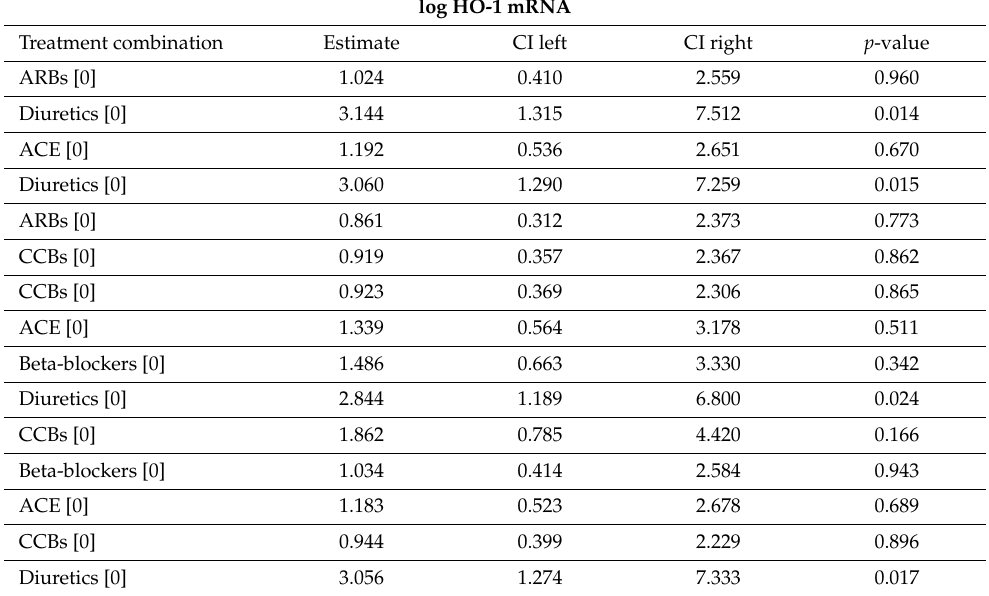
Table 1. Aortic HO-1 mRNA expression in response to prescription of different combinations of antihypertensive therapies in patients undergoing open surgical repair due to AAA. Data were analyzed by multiple linear regression, and HO-1 was set as the outcome variable. Data were log transformed, and one statistically significant outlier was omitted from the analysis. The estimate shows the proportional increase in HO-1 mRNA expression if the patient received the indicated therapy, whereas those that did not receive therapy serve as the reference level (=0). Abbreviations: ACE, angiotensin-converting enzyme; ARB, angiotensin II receptor blockers, CCB, calcium channel blockers, CI, confidence interval.